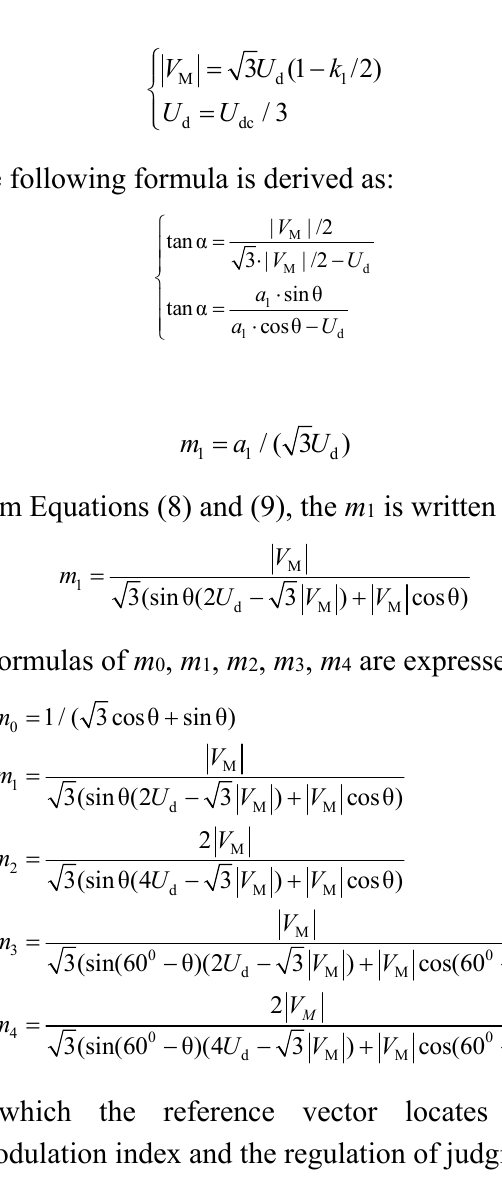
Table 1. Judging the small region of the reference